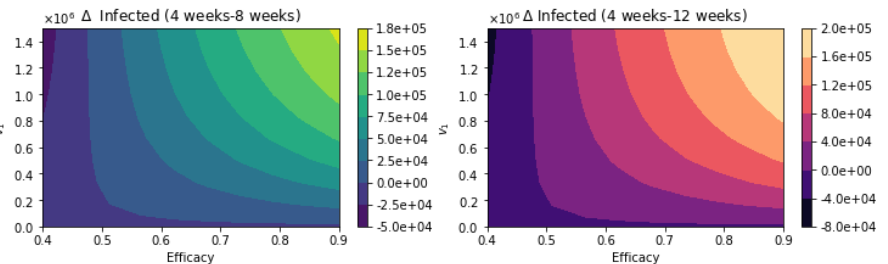
Figure 15. Differences between the total number of infected for the different vaccination regimens, and under a variety of vaccine efficacies after the first dose and different vaccination rates per day. The basic reproduction number R 0 > 1. Assuming that the asymptomatic and presymptomatic individuals have just 25% of infectiousness relative to symptomatic people [113].